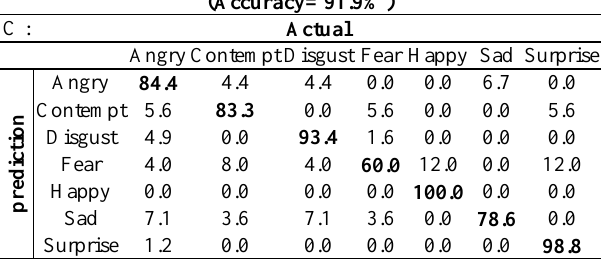
Table 4. Confusion matrices for FERS using LGP